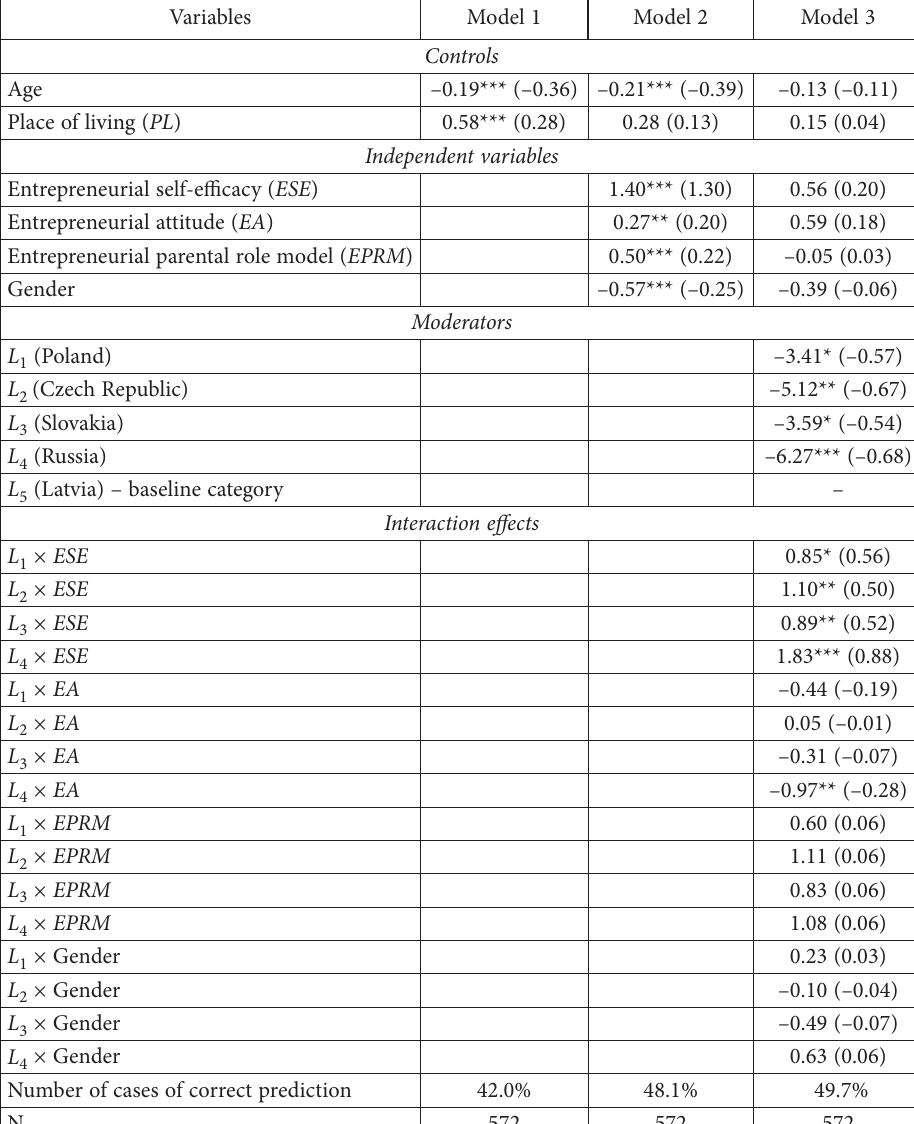
Table 5. Parameter estimates of hierarchical ordered logit